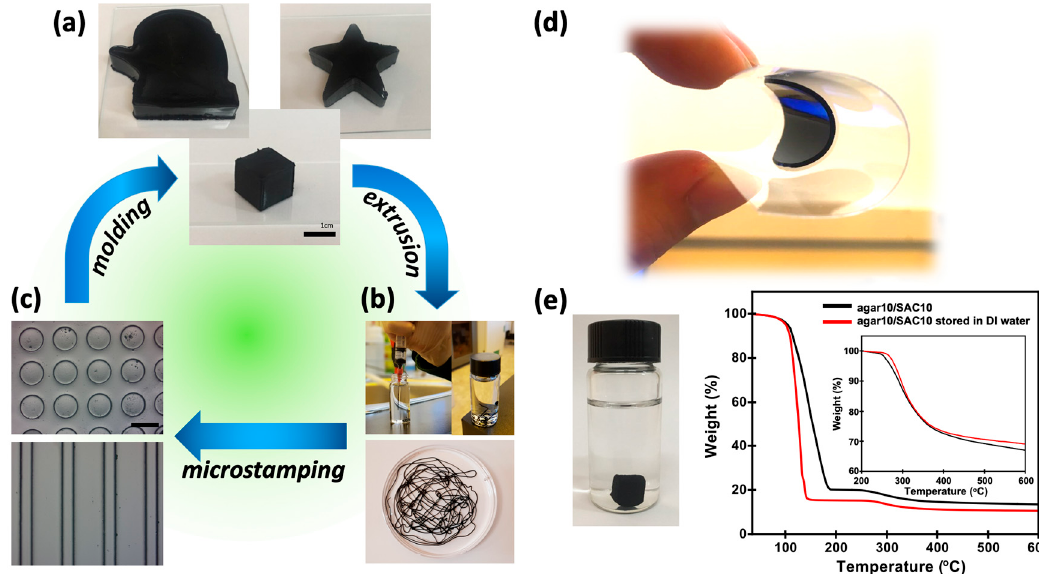
Figure 3. ( a – c ) Image gallery of the recyclable and shape-configurable agar / SAC composite gels using various engineering processes. ( a ) Photos of the agar10 / SAC10 composite gels with a mitten (left), star (right), or cube (middle) shape, prepared using the molding process. The scale bar indicates 1 cm. ( b ) Photos of the fibrous agar10 / SAC10 composite gels stored in water and prepared using an extrusion process. ( c ) Optical microscopy images of the agar10 / SAC10 composite gel prepared in circle (top) or line (bottom) patterns prepared using a microstamping process. The scale bar indicates 500 µ m. ( d ) Photo of the agar / SAC composite gel prepared on a flexible polyethylene terephthalate (PET) substrate. ( e ) TGA analysis of the as-prepared (black) and water-stored (red, left image) agar10 / SAC10 composite gels. (inset) The weight of the fully dried agar10 / SAC10 composite gel (W dry ) compared to the normalized weights of the two samples.